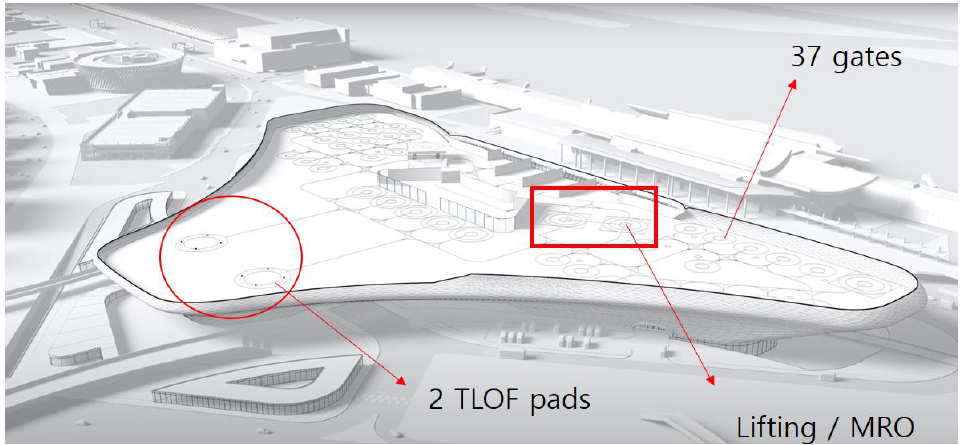
Figure 41. The lower deck design of the Gimpo Airport vertihub [21].